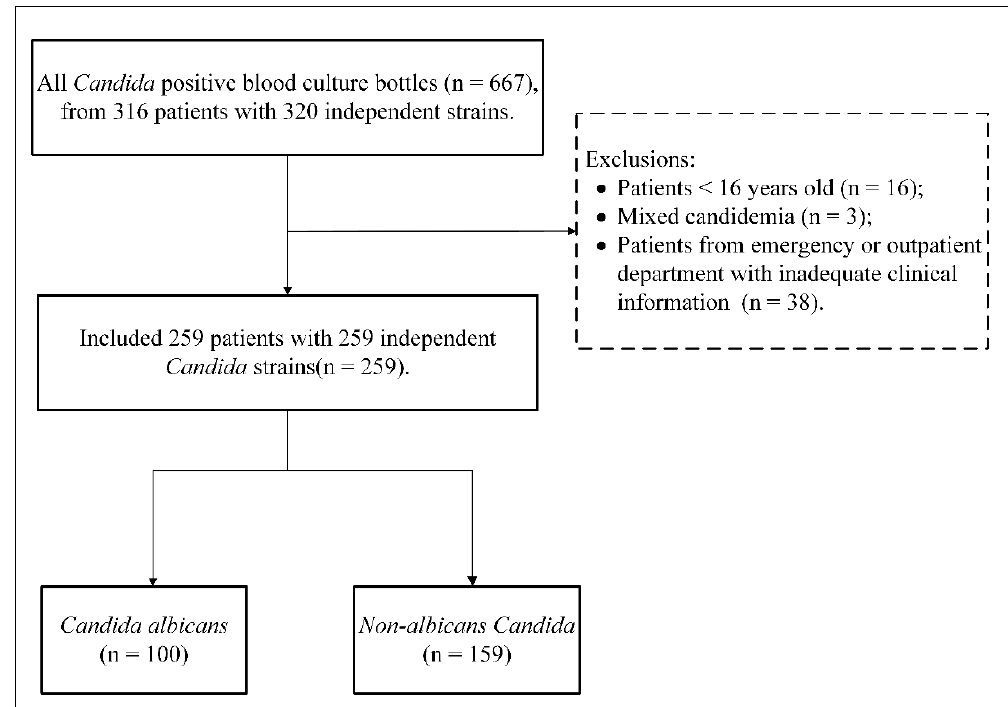
Figure 1. Flow chart of the comparative study from 2016 to